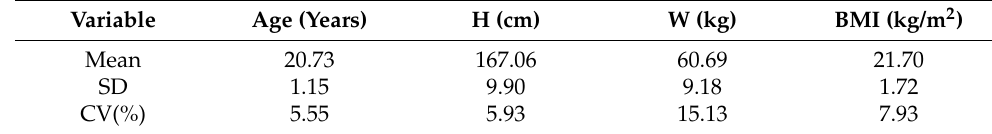
W, weight; H, height; SD, standard deviation; CV, coefficient of